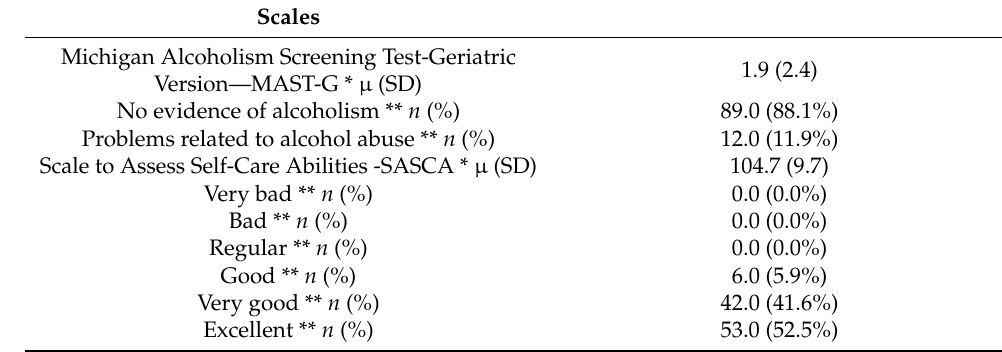
Table 1. Evaluation of alcohol use/abuse (MAST-G) and self-care abilities (SASCA) of elderly people enrolled at the Open University for Elderly People ( n =